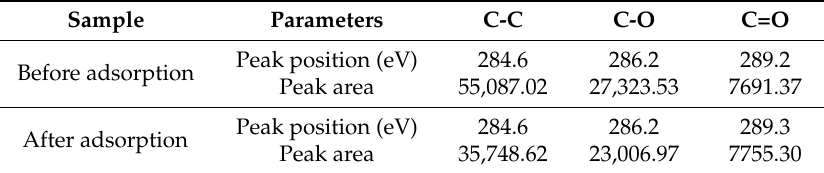
Table 3. C 1 s peak for WPAC before and after Cr(VI) adsorption at pH 3.